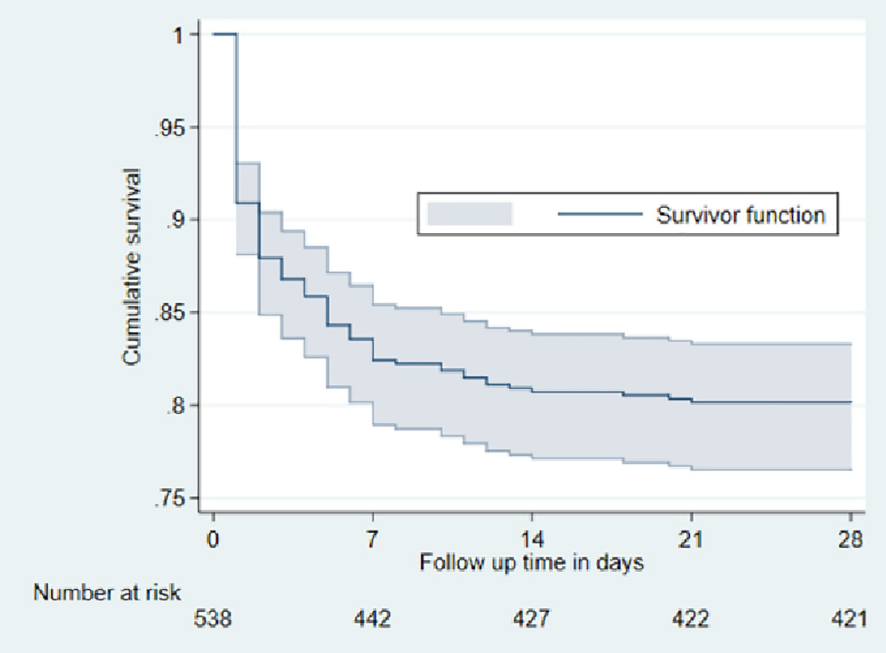
Fig 2. Cumulative survival curve of preterm neonates born at MRRH from October, 2019 to September, 2020 (n = 538).